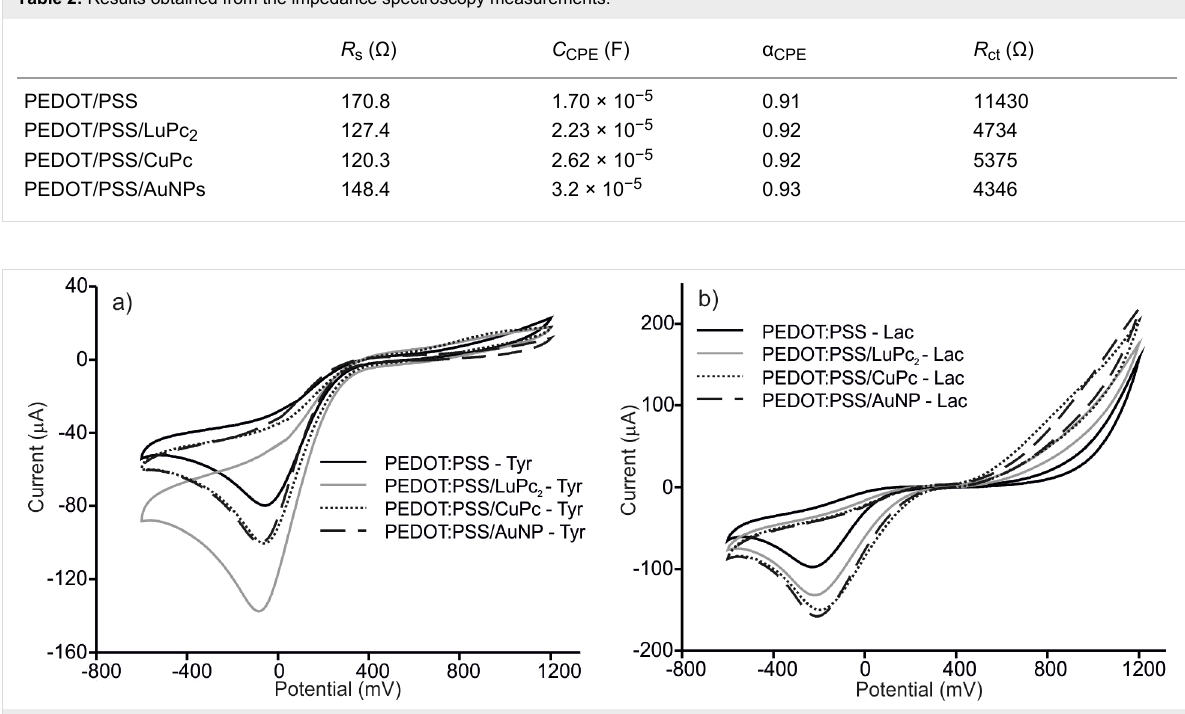
Table 2: Results obtained from the impedance spectroscopy measurements.